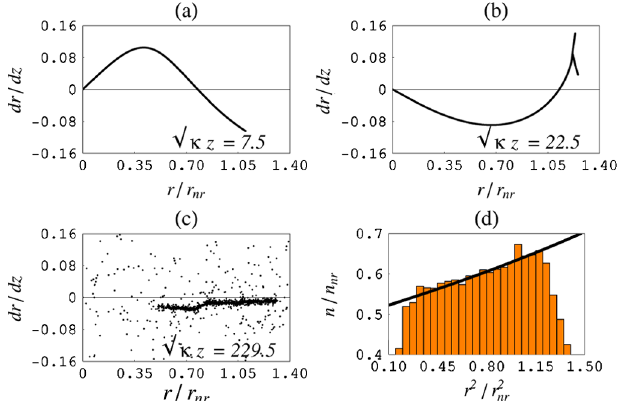
FIG. 2. Various snapshots of the phase space in (a)–(c), in- cluding wave breaking in (c). In (d), the density of the relaxed state is compared with the analytical result previously obtained. ¼ 0 : 995 and the other parameters are those used in Here, (cid:2) 0 Fig.